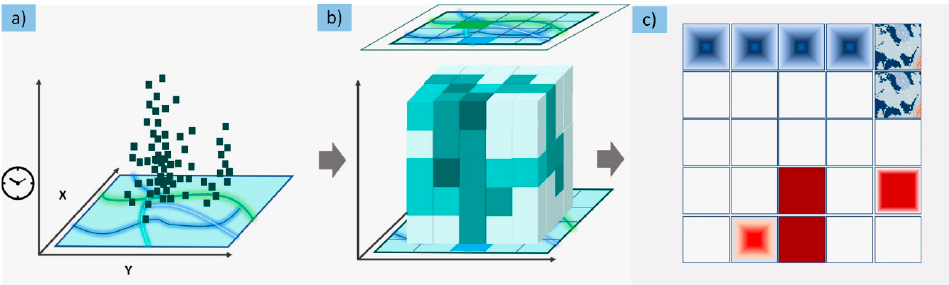
Figure A3. ( a ) Point data locations. ( b ) Generating STC with the output NetCDF format. ( c ) Running emerging hotspot analysis tool for generating hotspot with 17 possible classes. Based on [39], modified.